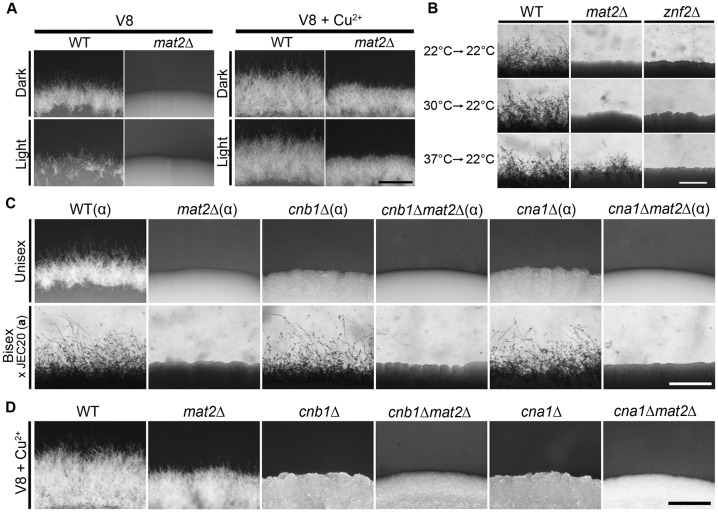
Influence on filamentation in the mat2Δ mutant by light, prior exposure to high temperature, and calcineurin.(A) WT and mat2Δ were cultured on V8 or V8+Cu2+ medium and incubated at 22°C in the dark or under constant light. (B) WT, mat2Δ, and znf2Δ were grown on YPD at 37°C, 30°C, or 22°C for 36 hours. Cells were transferred to V8 medium and incubated in the dark at 22°C for 8 days before the pictures were taken. (C) WT, mat2Δ, cnb1Δ, cnb1Δmat2Δ, cna1Δ, cna1Δmat2Δ of the α mating type were cultured on V8 medium either alone (unisex) or mixed with JEC20a (bisex) for 6 days. (D) The same strains as in panel C were cultured alone on V8+Cu2+ medium for 6 days. Scale bars: 500 μm.